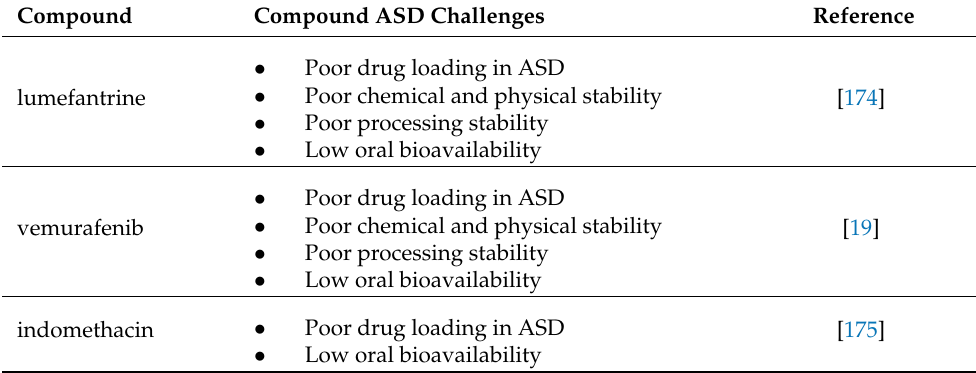
Table 6. Commercially available compounds for testing of new ASD polymers.